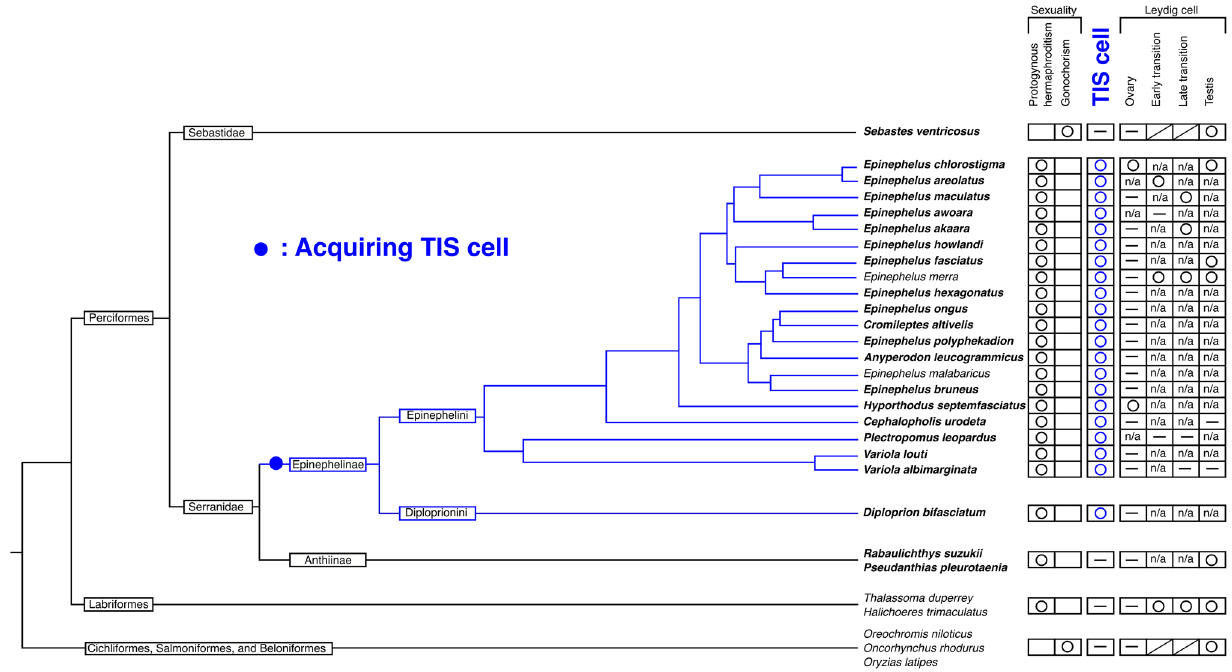
Figure 3. Phylogenetic position, sexuality, and existence of TIS and Leydig cells in fish gonads. The phylogenetic tree shows the evolutionary relationship among groupers, wrasses, and several gonochoristic fishes, following Ma et al. (2016) and Betancur et al. (2017) 22,24 . Species names in bold typeface indicate the results of the present study. The figures were constructed in Inkscape 1.0beta2 (https:// inksc ape.